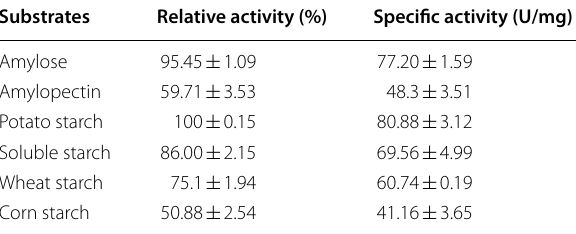
Table 1 Substrate specificity of the bl-GBE